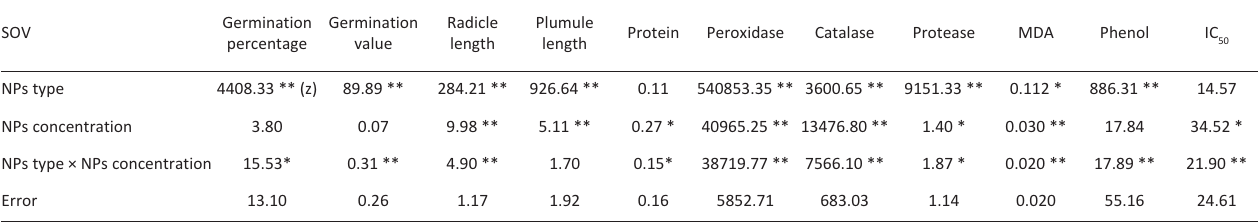
(z) The mean square values are